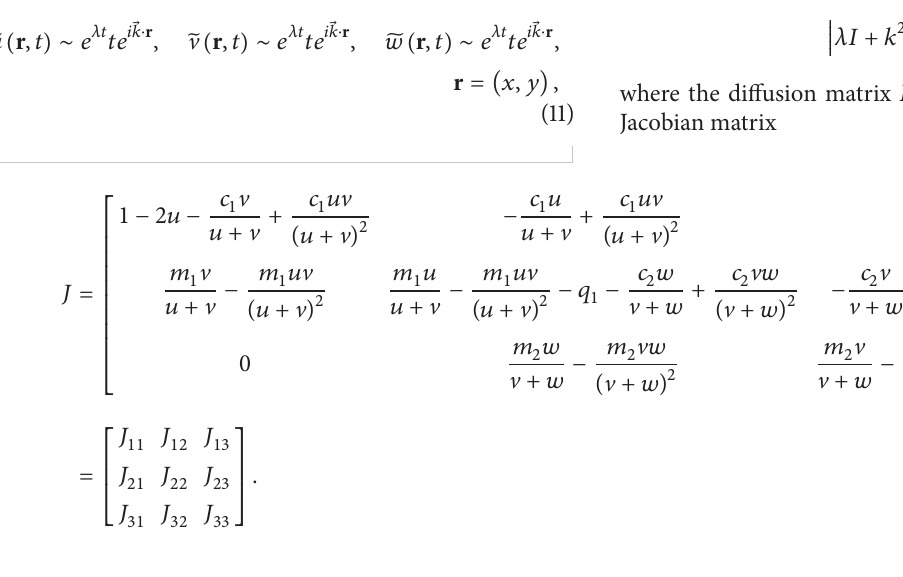
⃗𝑘⋅ ⃗𝑘 = 𝑘 2 , 𝑘 , and 𝜆 are the wave-number and frequency, where respectively.